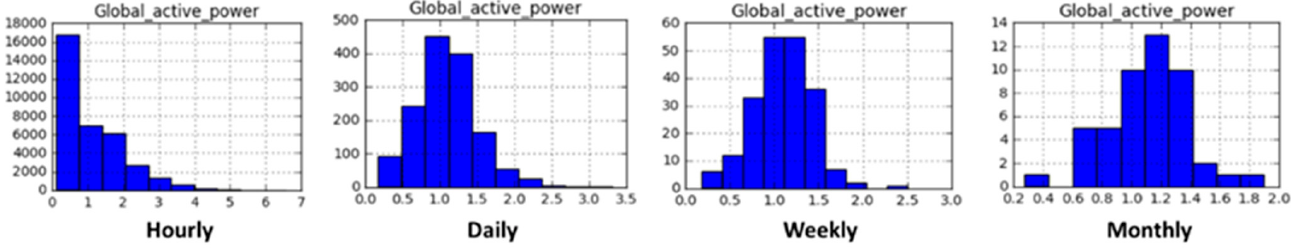
Figure 4. Visual presentation of total active power in the household dataset.